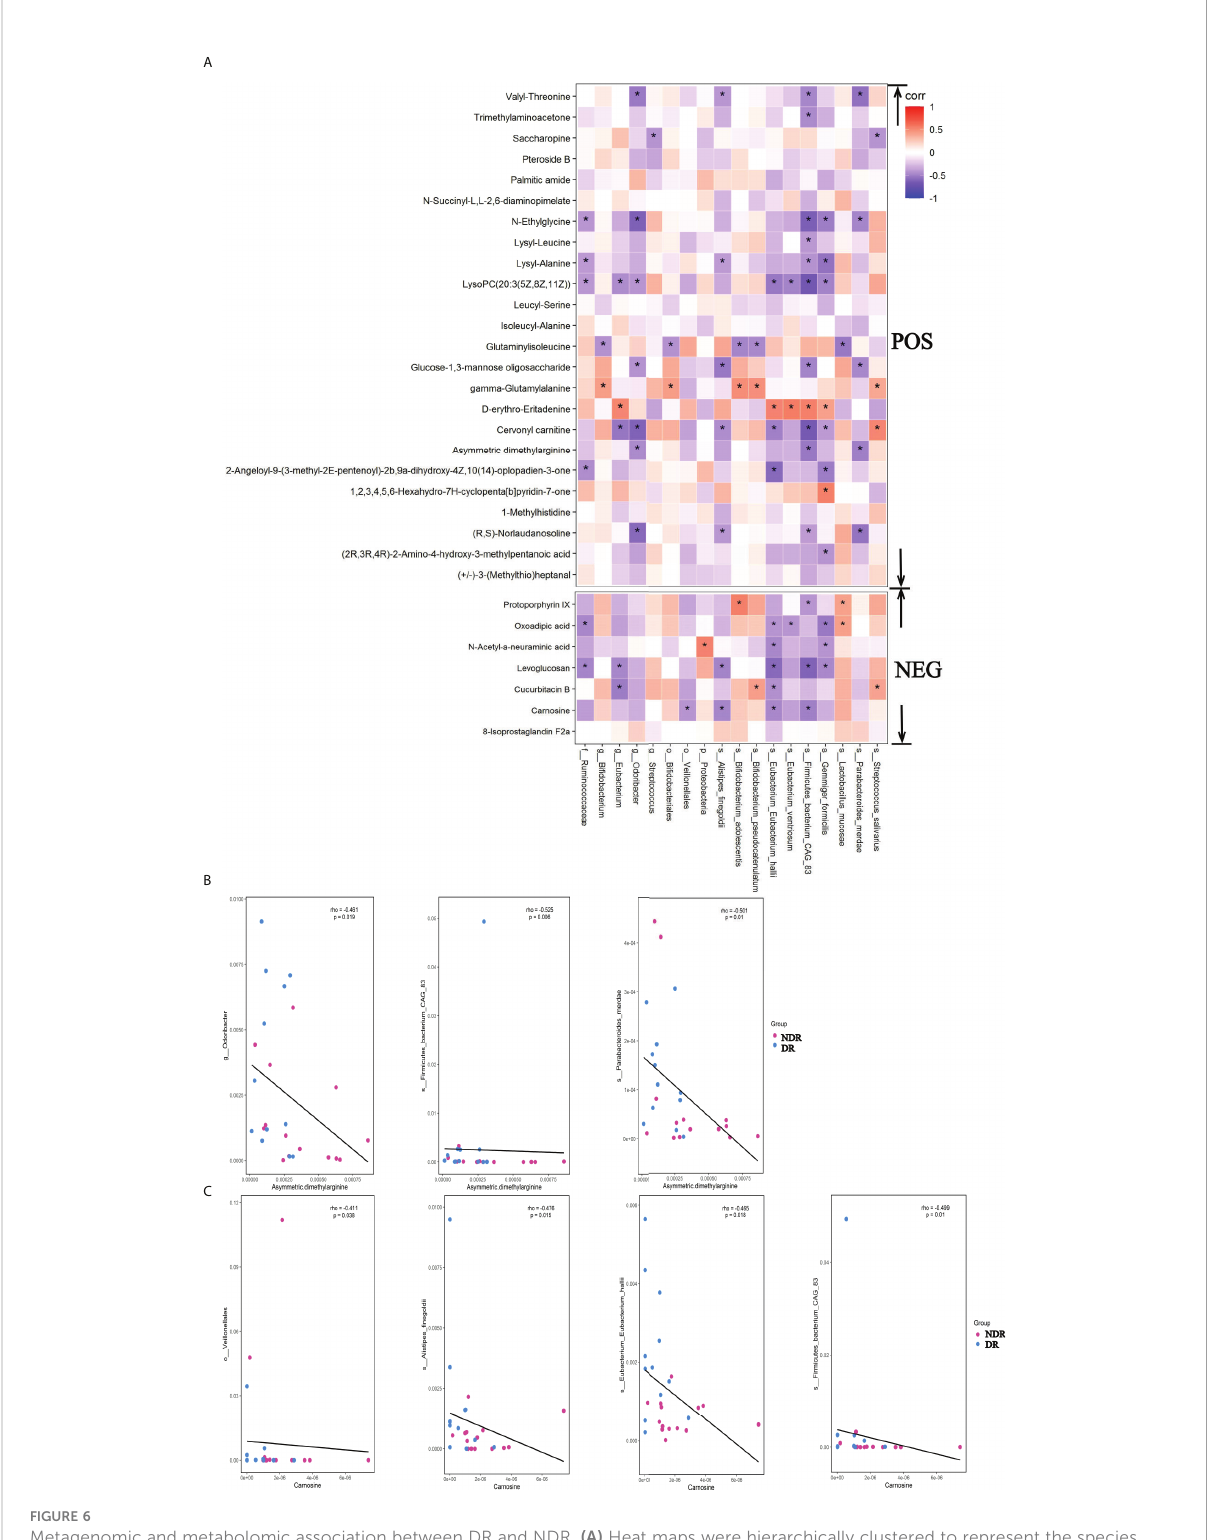
FIGURE 6 Metagenomic and metabolomic association between DR and NDR. (A) Heat maps were hierarchically clustered to represent the species metabolite-associated patterns based on the correlation distances. (B) The scatter plots of asymmetric dimethylarginine in the positive ion model with the associated micro fl ora (P < 0.05). (C) The scatter plots of carnosine in the negative ion model with the associated micro fl ora (P < 0.05).